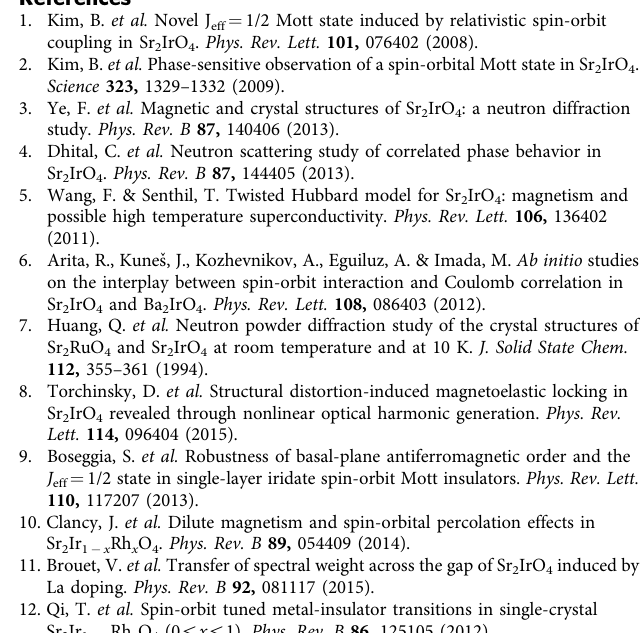
Supplementary Fig. 2b corresponds to a net ferromagnetic moment under 1T. This ferromagnetism originates from a canting of the AFM structure. The transition temperature is taken at the maximum slope in M ( T ) curve, that is, the minimum of the first derivative of magnetization, d M ( T )/d T shown in